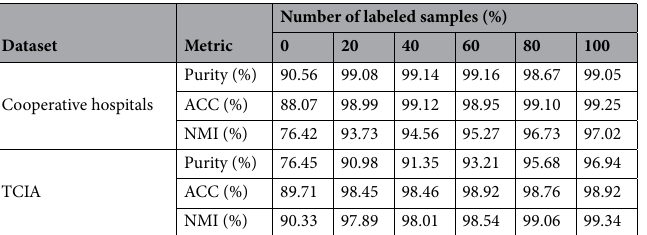
Table 3. Comparison of performance of label propagation algorithm with different number of labeled samples.